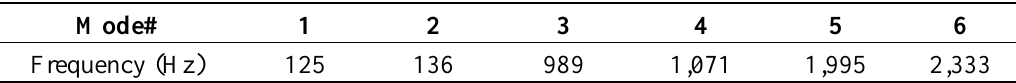
Table 2. The first six modes of the disc rotor